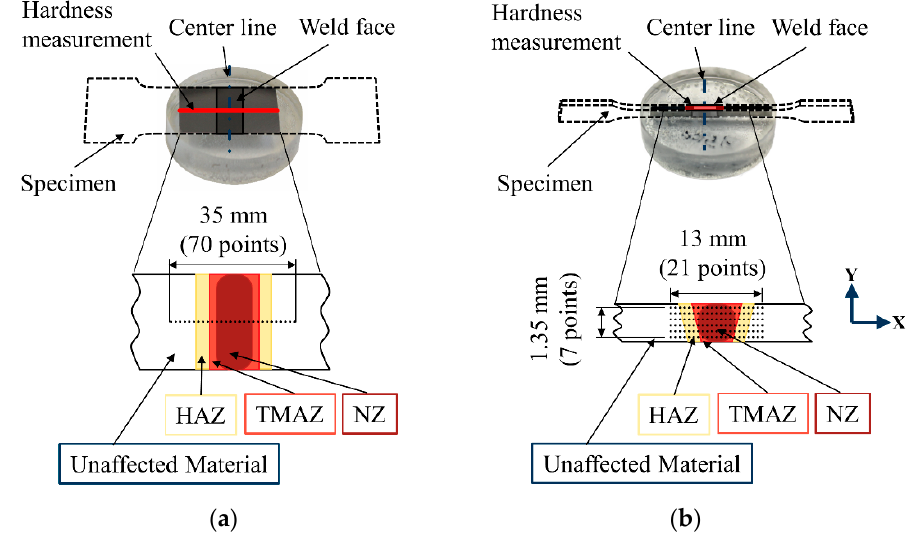
Figure 8. Configuration of the hardness measurement on the ( a ) surface and ( b ) the cross-section of the friction stir welded (FSW) specimens.